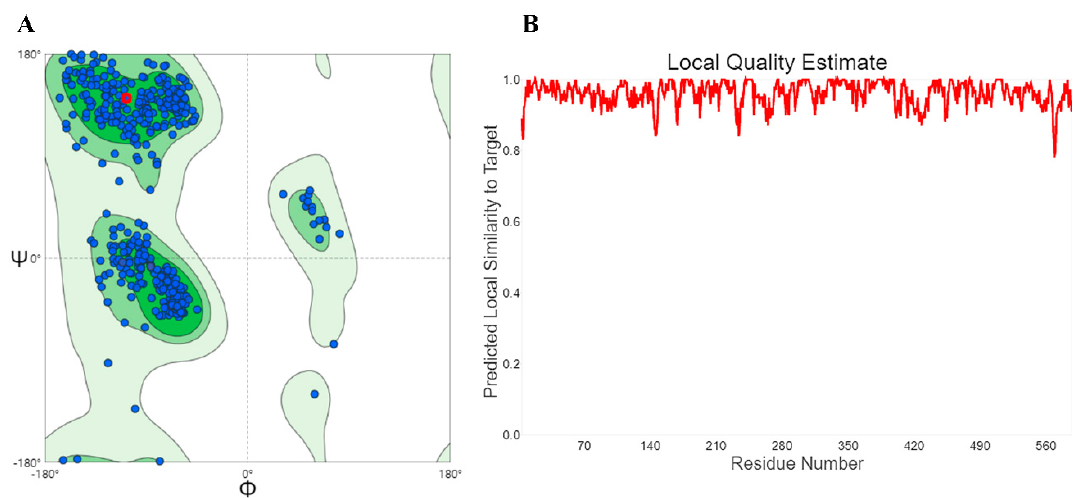
Figure 5. Homology modeling of α‐ glucosidase. ( A ) Ramachandran plot of the selected model protein. ( B ) The local quality estimate of the selected model protein.